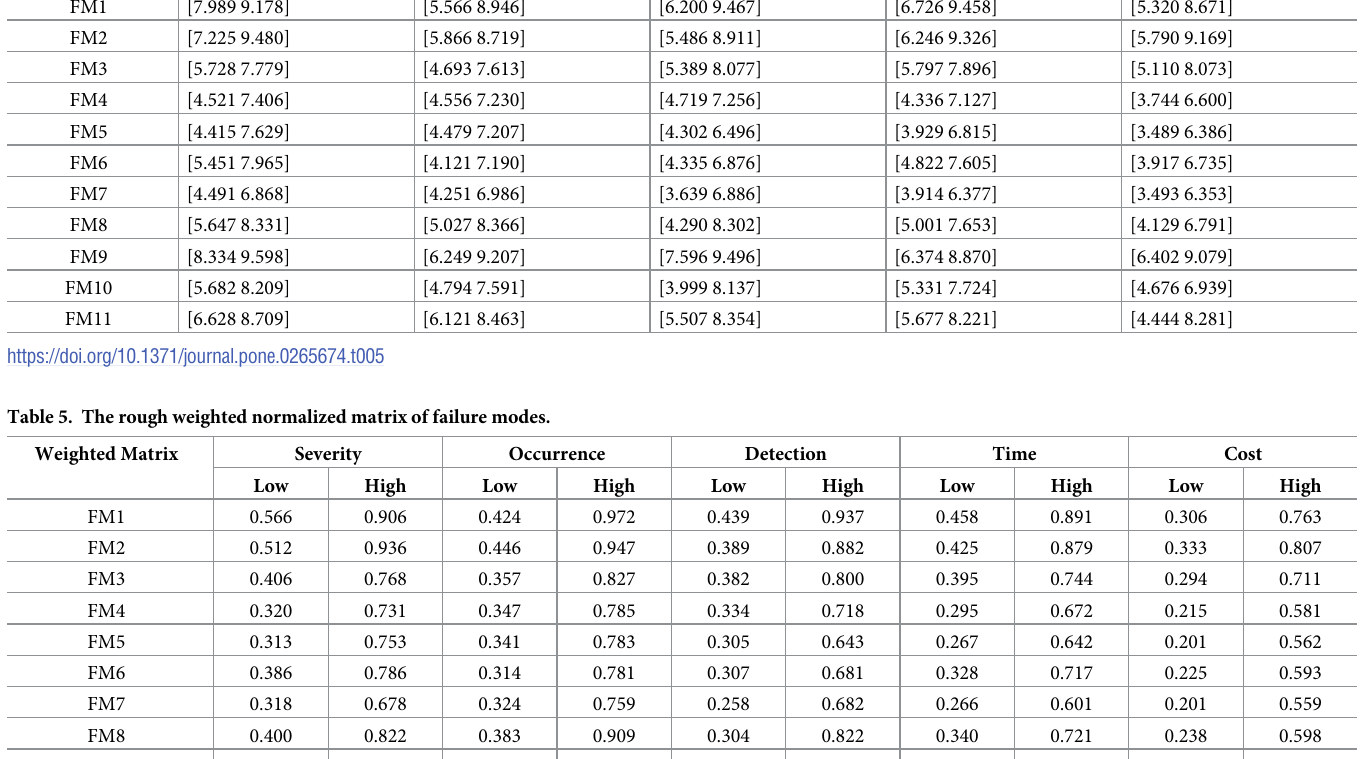
Table 4. The evaluation matrix of rough failure modes.